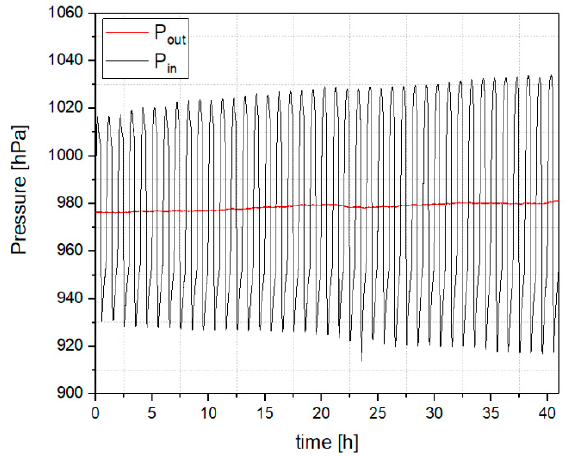
Figure 8. Pressure variation in the battery housing and climatic chamber in case of the sealed battery system during abnormal operation.